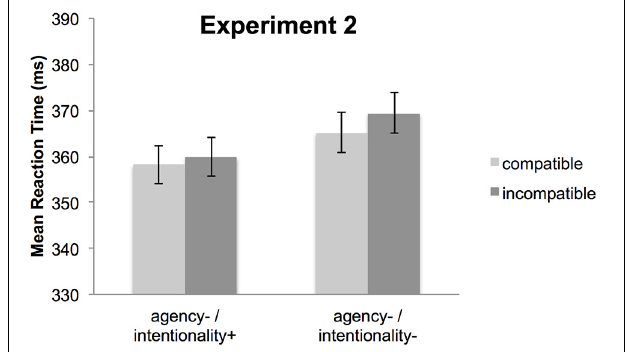
FIGURE 4 | Mean reaction times for Experiment 2. Depicted are compatible (light gray) and incompatible (dark gray) trials for the agency − /intentionality + condition (left panel) and the agency − /intentionality − condition (right panel). Error bars represent standard errors of the mean differences (Pfister and Janczyk,